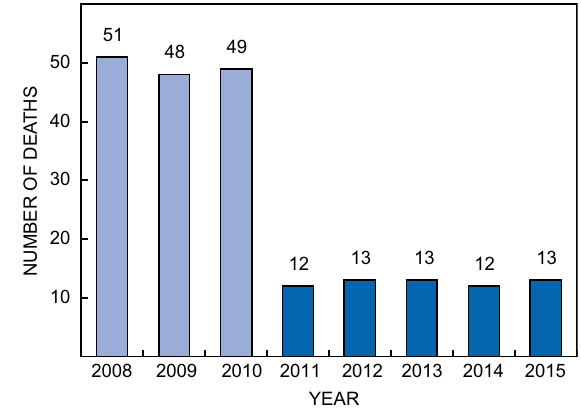
Figure 1: Number of deaths per year during the overall study period.